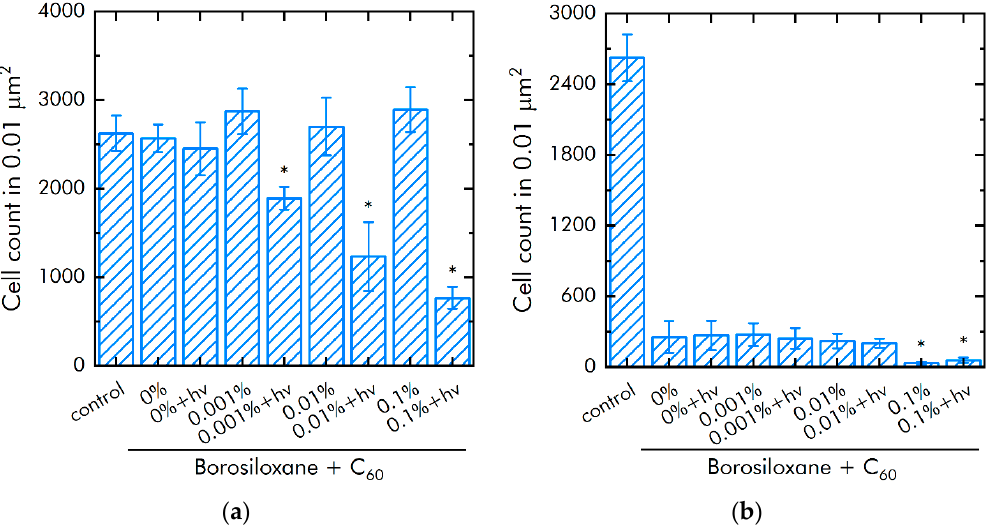
Figure 9. Influence of composite material based on borosiloxane and fullerenes on the growth and development of E. coli : ( a ) Development of Escherichia coli . Incubation time is 24 h; ( b ) Effect of tearing off bacteria from a substrate using a composite material based on borosiloxane and fullerenes; * indicate a significant difference at 5% level in comparison with the control ( p <0.05). Data are presented as mean values and standard errors.